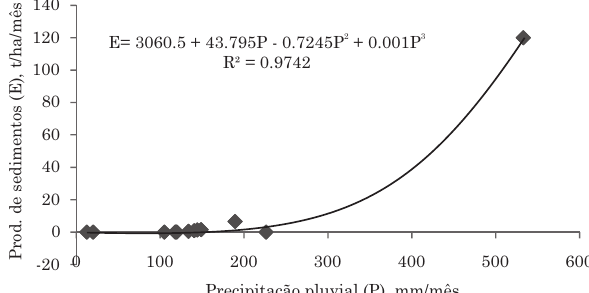
Figura 2. Relação entre a precipitação pluvial média mensal e a produção de sedimentos mensal